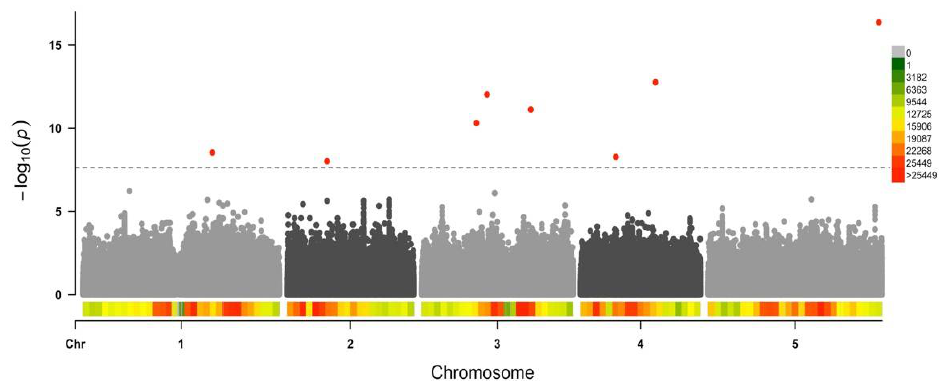
Figure 4. Manhattan plot illustrating the Arabidopsis thaliana genomic regions associated with CMV virulence. Dashed line indicates false discovery rate (FDR) threshold. Color scale represents single nucleotide polymorphism (SNP) density.